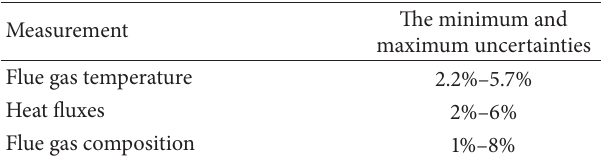
Figure 5: A sketch of the structure of the suction pyrometer including essential parts. Table 2: Uncertainty limits for each measured parameter at 1300 ∘